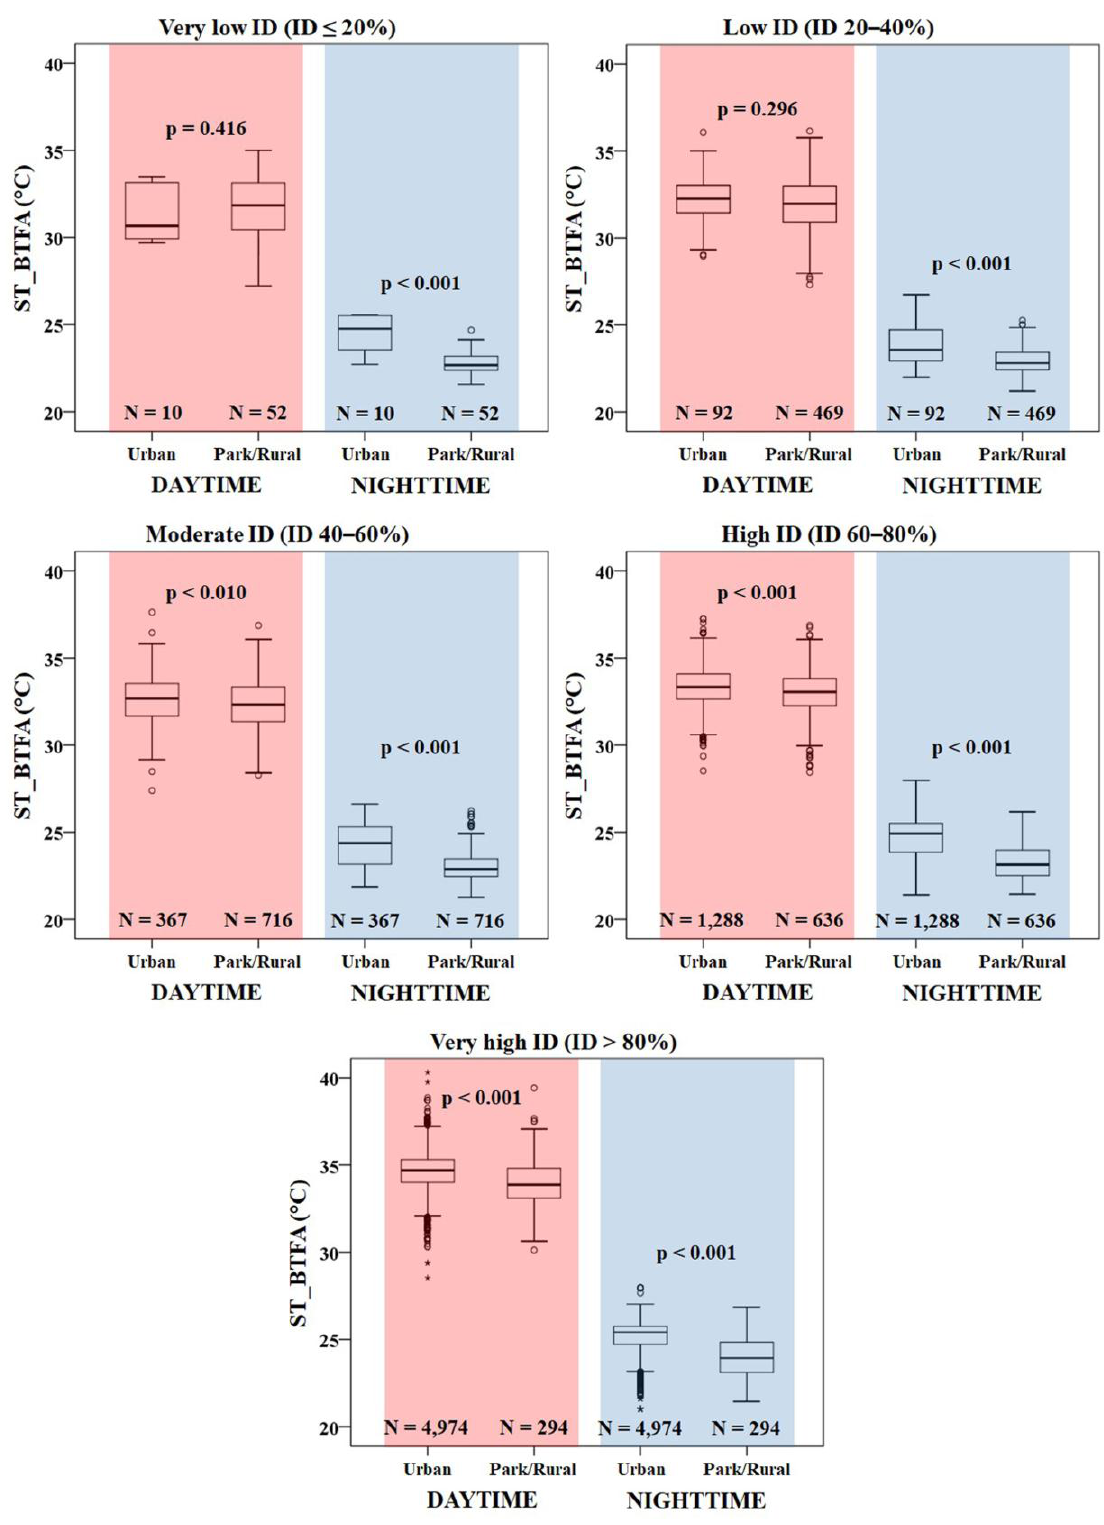
Figure 7. Boxplot charts related to the surface temperature nearby residential buildings (ST_BTFA) observed in urban and park/rural areas during daytime (highlighted in red) and nighttime (highlighted in blue) in the five imperviousness density (ID) groups. N is the number of BTFA considered in different ID groups and urban zones. Significant levels ( p -value) between urban and park/rural ST_BTFA values were reported.